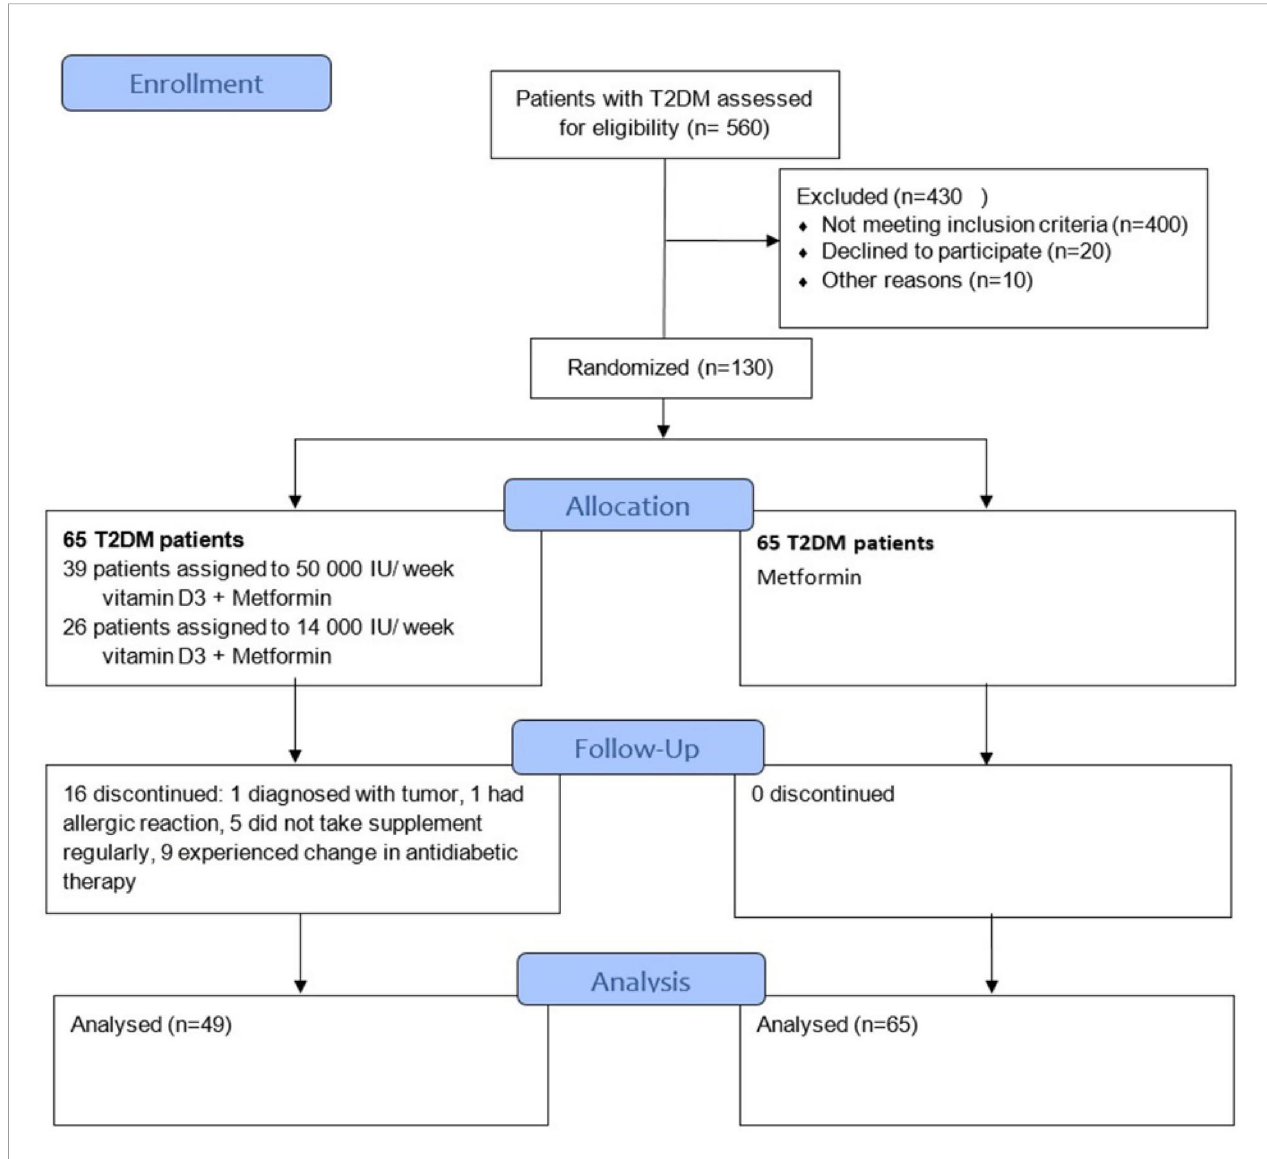
FIGURE 1 | Participant fl owchart and study